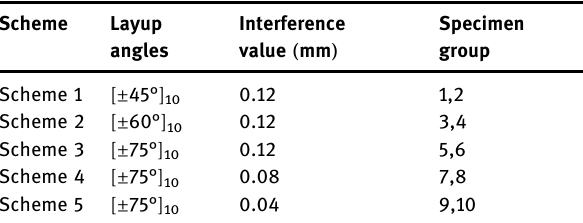
Table 7: Schemes for interference fi t joints Scheme